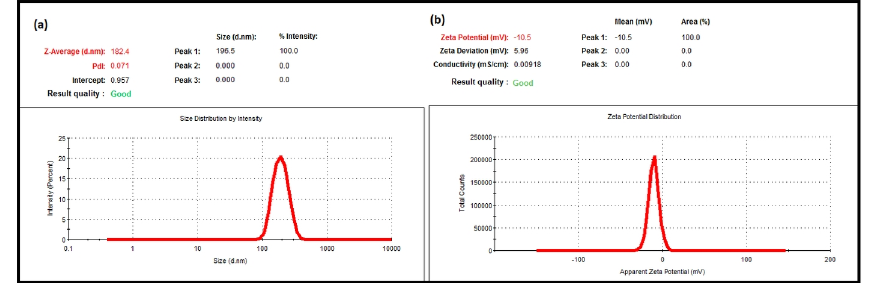
Figure 1. The projected band structure of the MoTe 2 /PtS 2 vdWH with the ( a ) P1, ( b ) P2, ( c ) P3, Figure 1. DLS analysis of the blank NPs: ( a ) average particle size, and ( b ) zeta potential graphs. ( d ) P4, ( e ) P5 and ( f ) P6 stacking configurations.